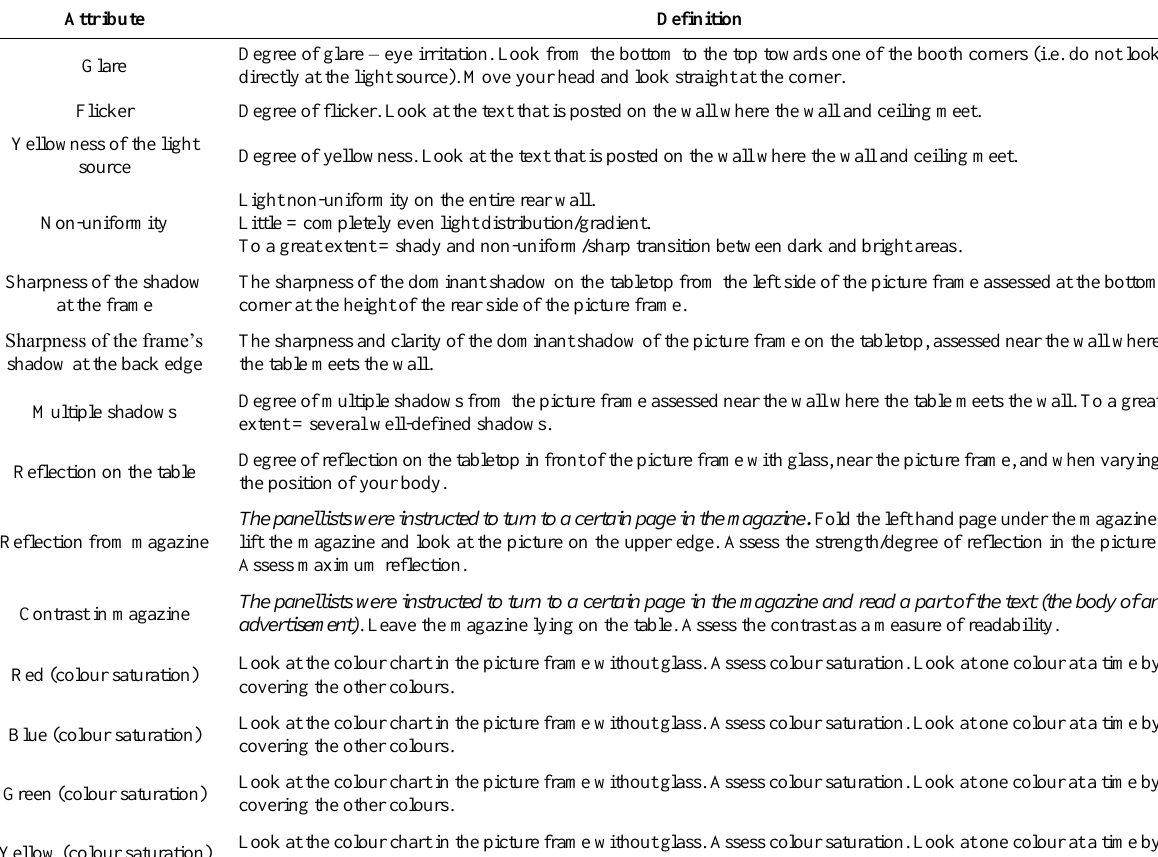
Yellow (colour saturation) Table 2. Attributes and definitions used in the assessments in sub-studies 2 and 3 in 2017 and 2018 Attribute Definition Light colour, warm Light colour, reddish